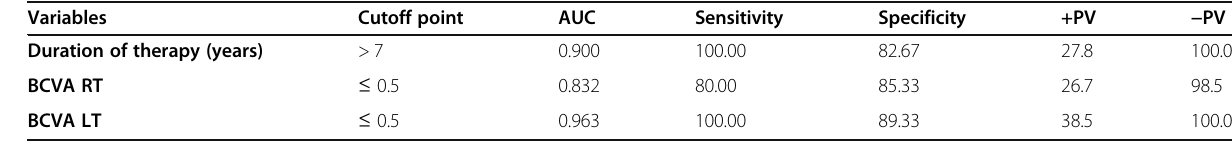
Table 5 Receiver operating characteristic curve (ROC) for predictors of abnormal FAF cases Variables Cutoff point AUC Sensitivity Specificity +PV − PV Duration of therapy (years) > 7 0.900 100.00 BCVA RT ≤ 0.5 0.832 BCVA LT ≤